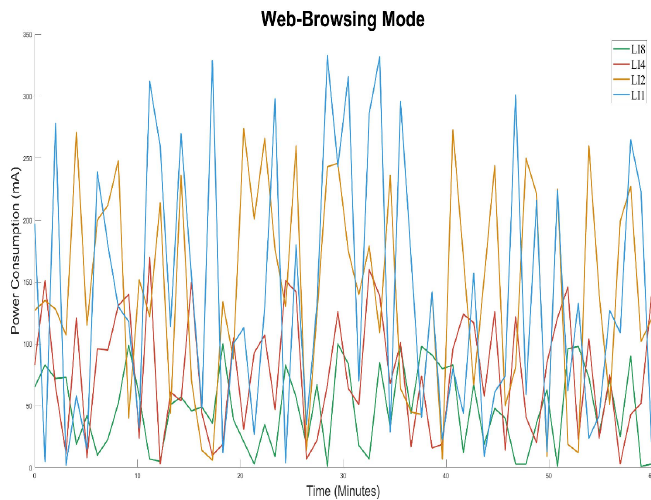
Figure 15. Station Power Consumption in web-browsing mode. An Asus AP is taken to connect the station device (configuration shown in Table 2).